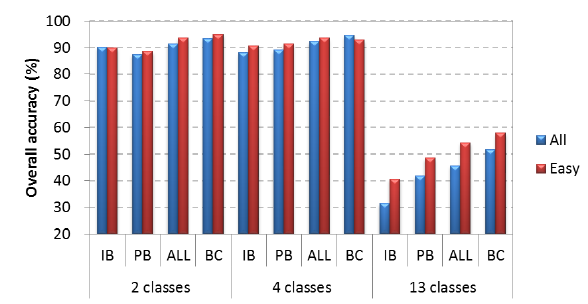
Figure 6. Comparison of the tree species classifications of all trees with easily detected trees